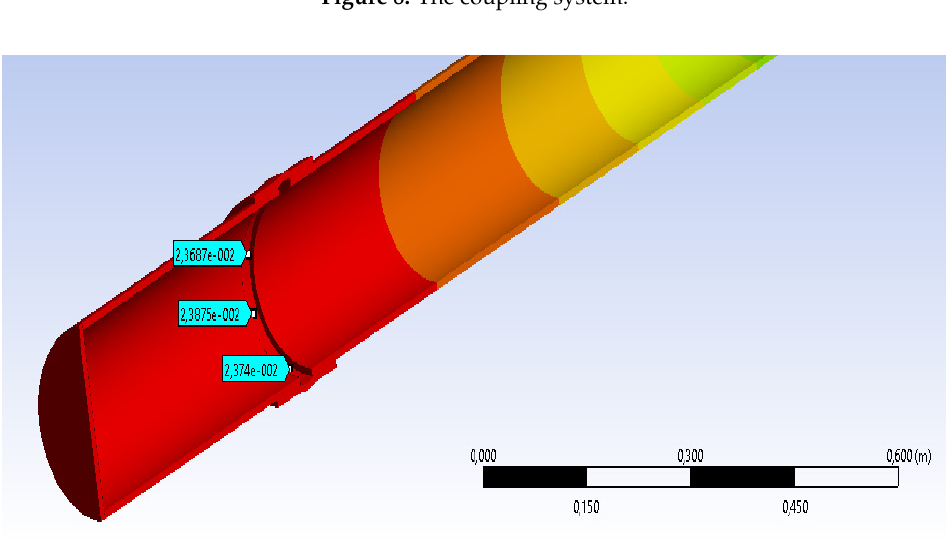
Figure 8. The coupling system.